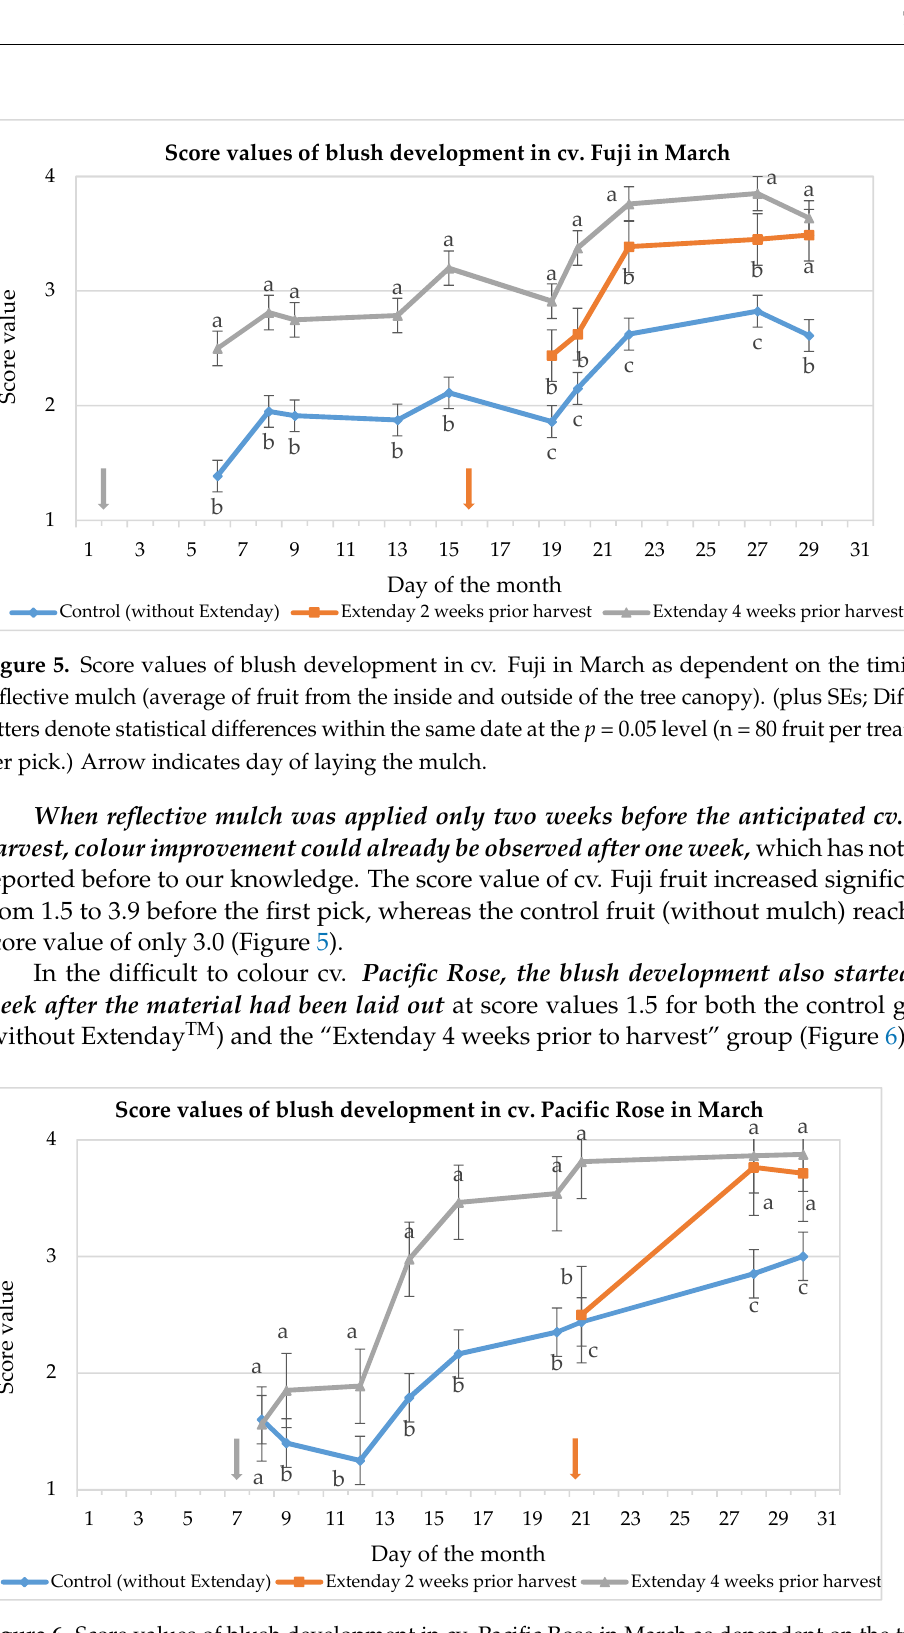
Figure 6. Score values of blush development in cv. Pacific Rose in March as dependent on the timing of reflective mulch (average of fruit from the inside and outside of the tree canopy) at Motueka (NZ). (plus SEs; Different letters denote statistical differences within the same date at the p = 0.05 level (n = 80 fruit per treatment per pick.) Arrow indicates day of laying the mulch. Table 1. Percentage blush of cv. Fuji apple at each pick dependent on fruit position within the canopy. Fruit Position within the Tree Canopy